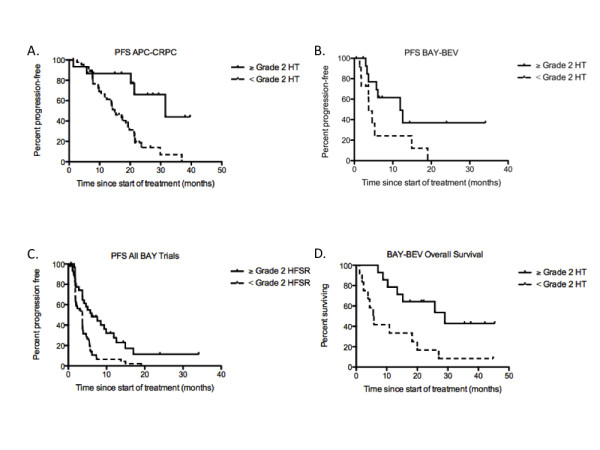
Kaplan-Meier curve of progression-free survival following treatment with bevacizumab in combination with docetaxel and thalidomide, n = 60 (A), or bevacizumab in combination with sorafenib, n = 27 (B), or sorafenib alone or in combination with bevacizumab, or cetuximab in patients with prostate cancer, various solid tumors, colon cancer, or NSCLC n = 113 (C), or overall survival following treatment with bevacizumab in combination with sorafenib, n = 26 (D) versus development of ≥ Grade 2 toxicity - - or < Grade 2 toxicity ------ as indicated on each respective figure. Respective P = 0.0009, P = 0.052, P = 0.0003, and P = 0.0068 by a two-tailed log-rank test.